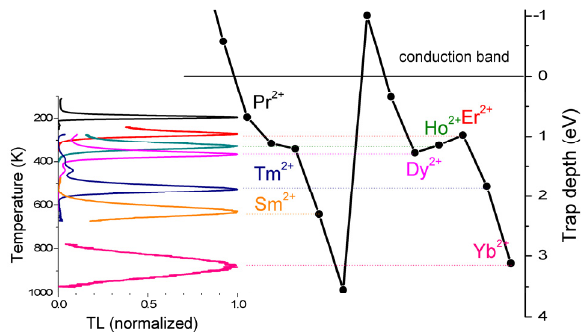
Figure 6. Comparison of predictions of the trap depth of the energy level scheme (the zigzag curve) and experimentally measured glow peak maxima. The codopant and corresponding glow peak have the same color.